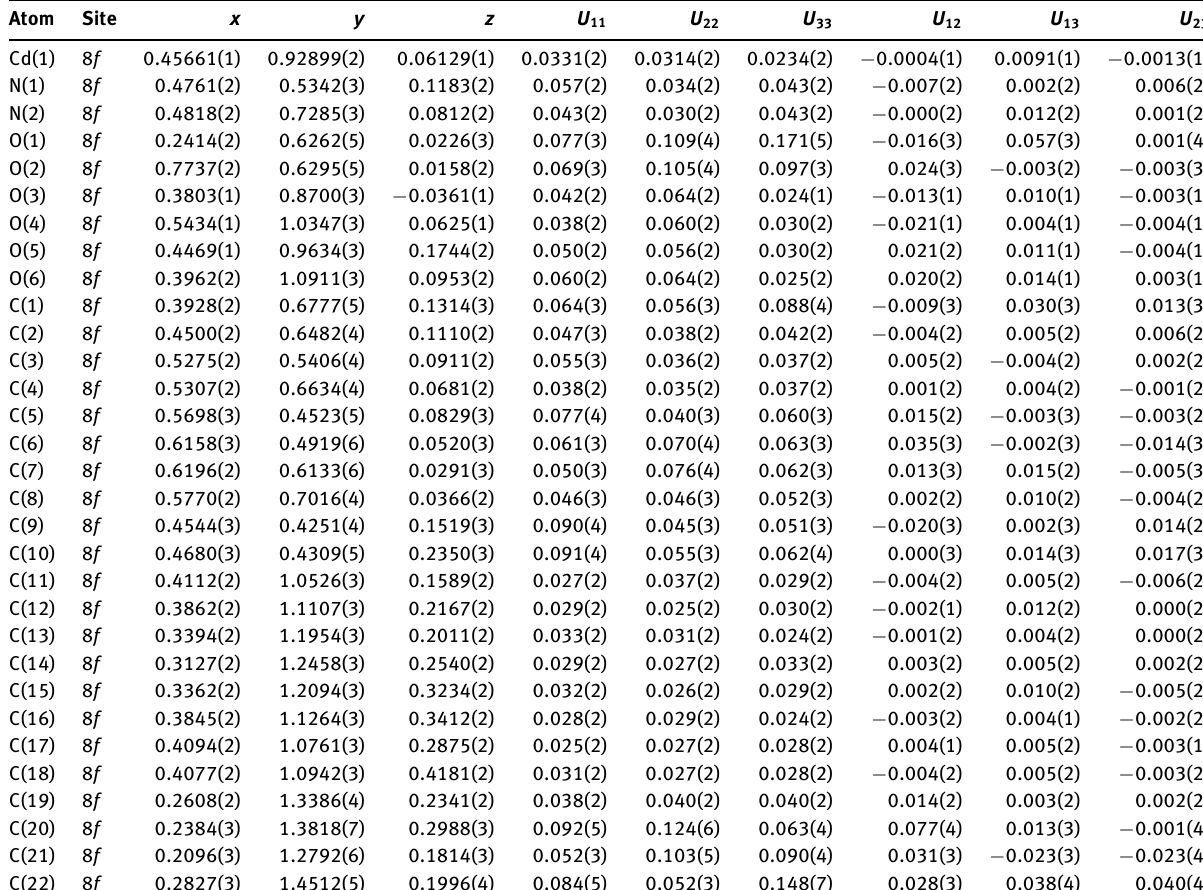
Table 3: Fractional coordinates and atomic displacement parameters (Å 2